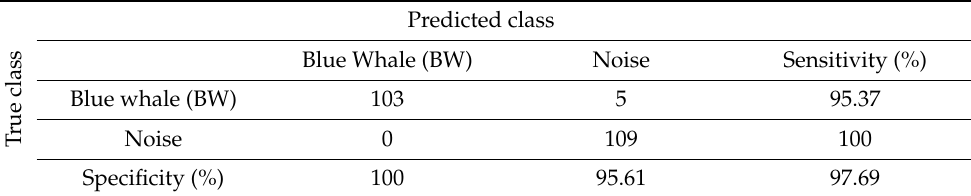
Table 2. The confusion matrix for the proposed method with the ‘Blue whale (BW) + Noise’ dataset (the accuracy (%) is indicated in bold font and calculated as a ratio of the sum of diagonal values to the sum of all values × 100).